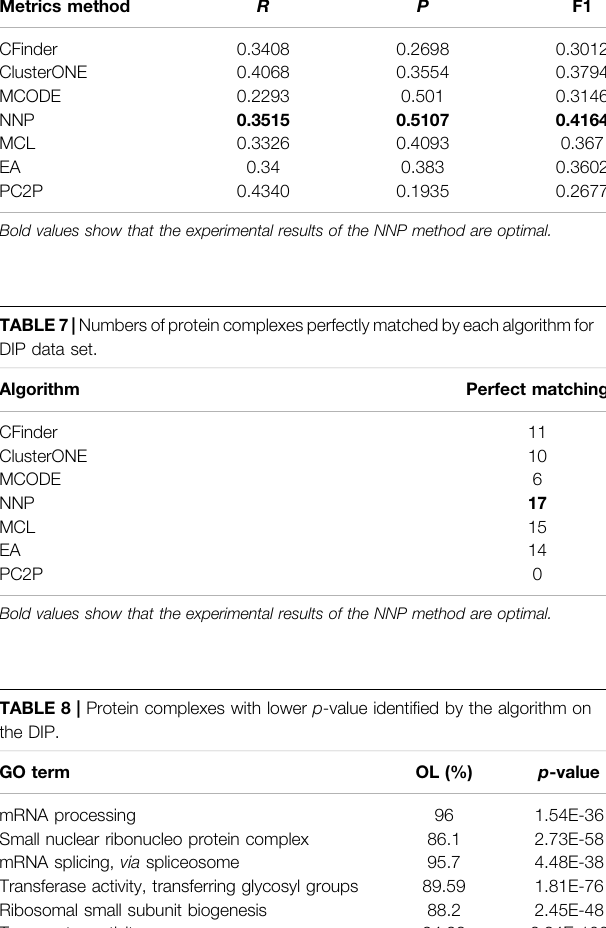
TABLE 6 | Results of protein complexes recognized by algorithms. Metrics method